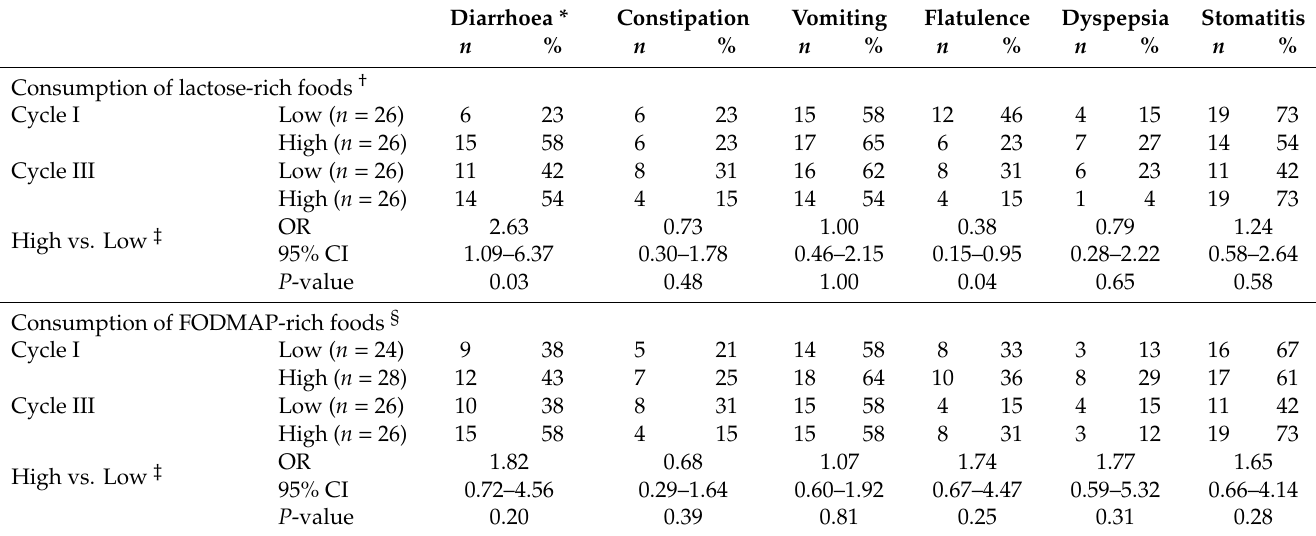
Table 2. Prevalence of chemo(radio)therapy-related gastrointestinal symptoms of at least mild intensity (Grade 1–4) during cycles I and III according to the consumption of lactose-rich and FODMAP-rich foods in 52 colorectal cancer patients (univariate